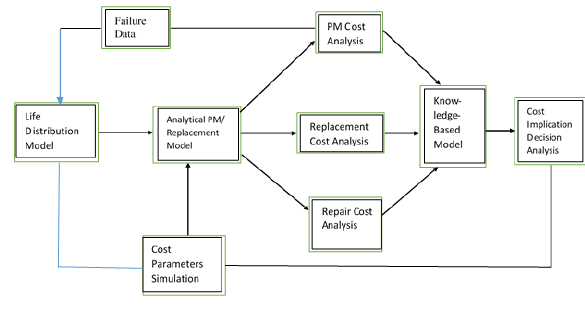
Fig. 1. Knowledge-based framework